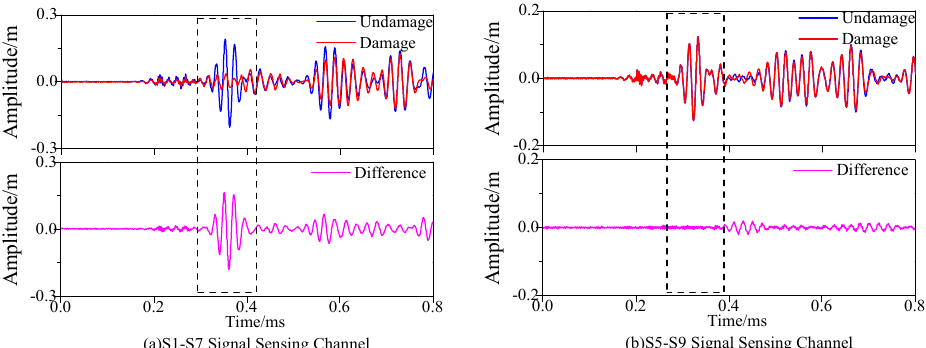
Figure 9. Response signals with different sensing channels. ( a ) S1–S7 Signal Sensing Channel ( b ) S5–S9 Signal Sensing Channel.